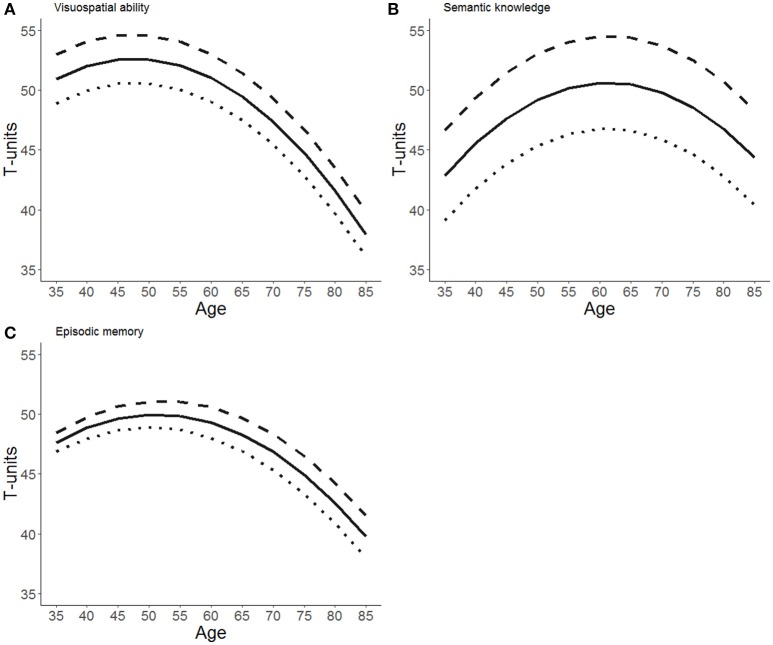
Model-implied growth trajectories for (A) visuospatial ability, (B) semantic knowledge, and (C) episodic memory. Trajectories apply to men born in 1935 with 3 years more than average education (dashed line), average education (solid line), and 3 years less than average education (dotted line).